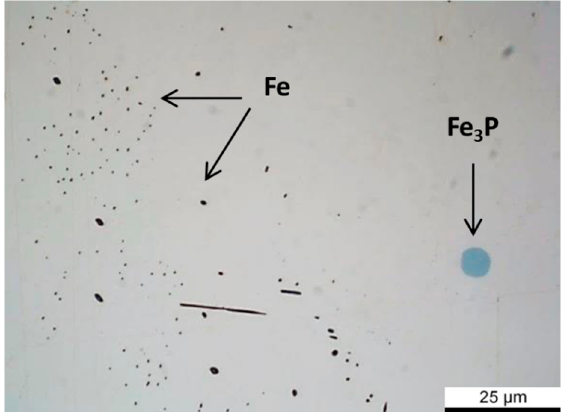
Figure 9. Microstructure of Cu–Fe–P alloy after homogenization. The majority of submicron particles are dissolved. Coarse Fe 3 P particles remain undissolved while Fe particles with increased size appear.